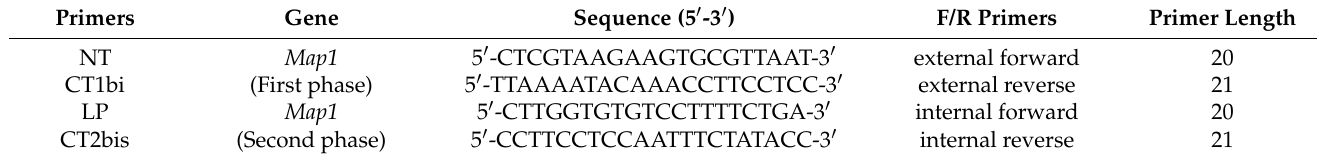
Table 1. Primer sequences for the detection of the Map1 gene using conventional nested